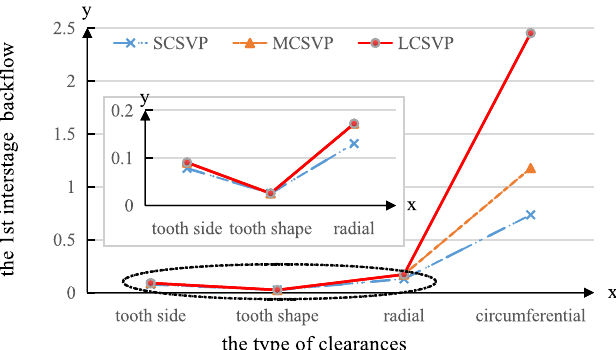
Fig. 14. Comparison of 1st stage back fl ow between four types of clearances.